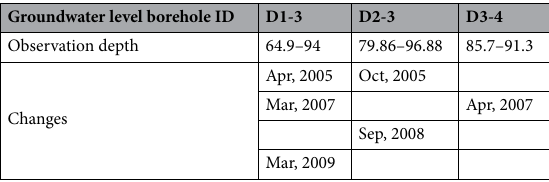
Table 2. Change points of groundwater level boreholes.